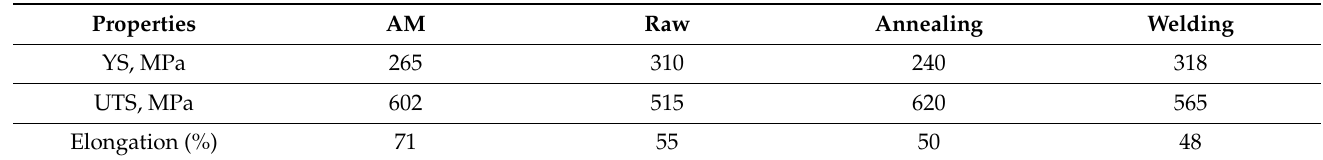
Table 2. Comparison of data on mechanical properties of stainless steel under different manufacturing conditions [93,94].